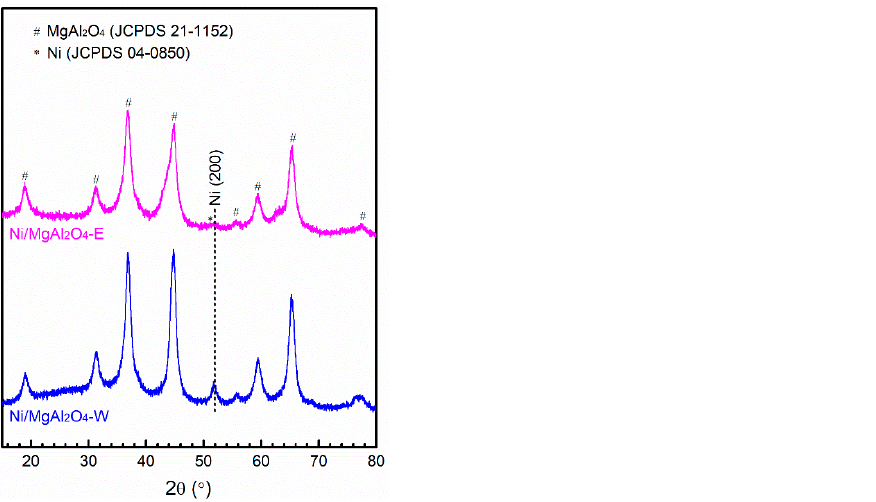
Figure 1. XRD patterns for the Ni/MgAl 2 O 4 -W and Ni/MgAl 2 O 4 -E samples.